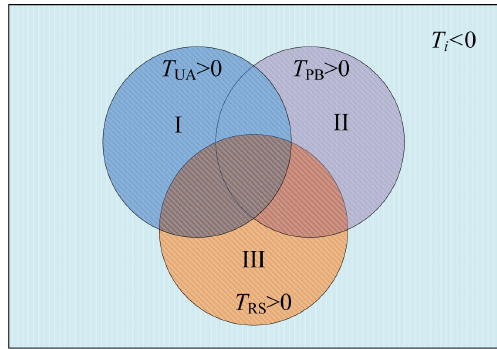
Figure 4. Operation areas of GCUA-T 3-joint finger.